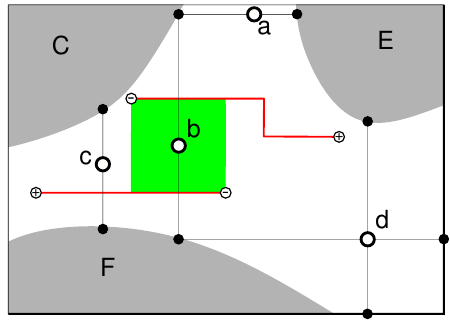
Figure 5. The linear discontinuity indicator in different cases. Horizontal κ x = 0 on point a , vertical κ y = 0 on point b , κ y (cid:54) = 0 on point c , and κ x and κ y both undefined on point d . The lines in red mark two discontinuity boundaries, and the area in green defines a dangerous